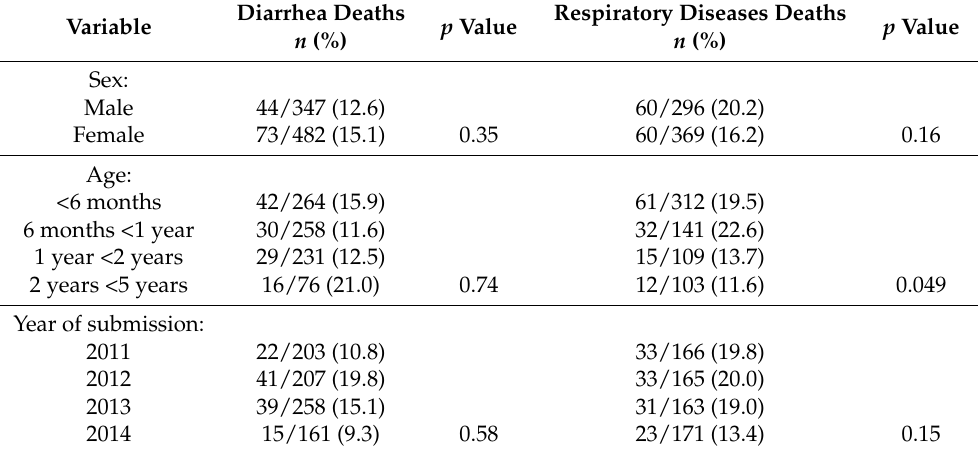
Table 4. Case fatality rates due to diarrhea and respiratory diseases, stratified by sex, age and year of